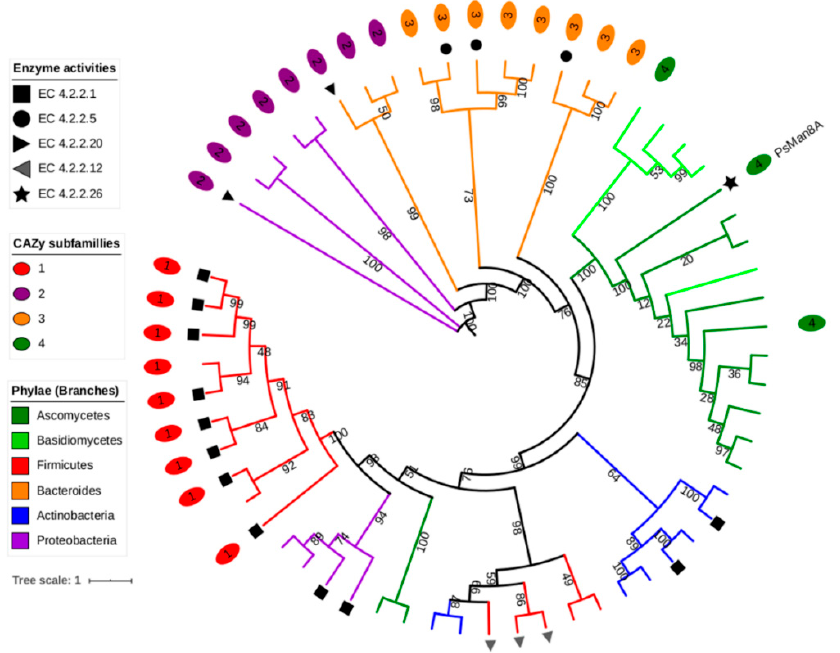
Figure 3. Maximum likelihood phylogenetic tree of selected PL8 protein sequences from the CAZy database including subfamily and EC number classifications. Due to the limited number of reported fungal PL8 sequences in CAZy, some additional putative fungal PL8 sequences were added from GenBank, found by Blastp analysis and subsequent PL8 HMM analysis. Enzyme activities correspond to EC numbers as follows; 4.2.2.1 = hyaluronate lyase, 4.2.2.5 = chondroitin AC lyase, 4.2.2.20 = chondroitin ABC lyase, 4.2.2.12 = xanthan lyase, 4.2.2.26 = Exo-acting polyM lyase. Numbers on branches represent bootstrap values. The tree scale bar indicates substitution changes per site. A dendrogram including accession numbers for all sequences is shown in Figure S2.